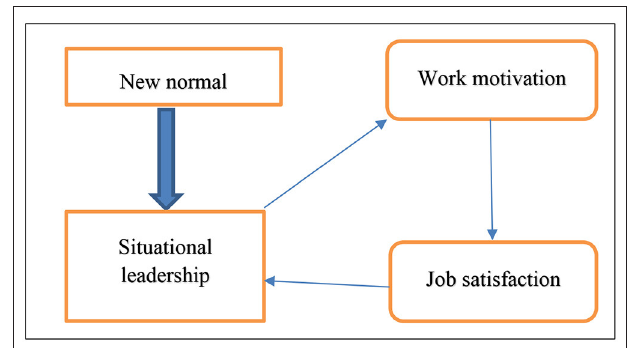
FIGURE 1 | Conceptual